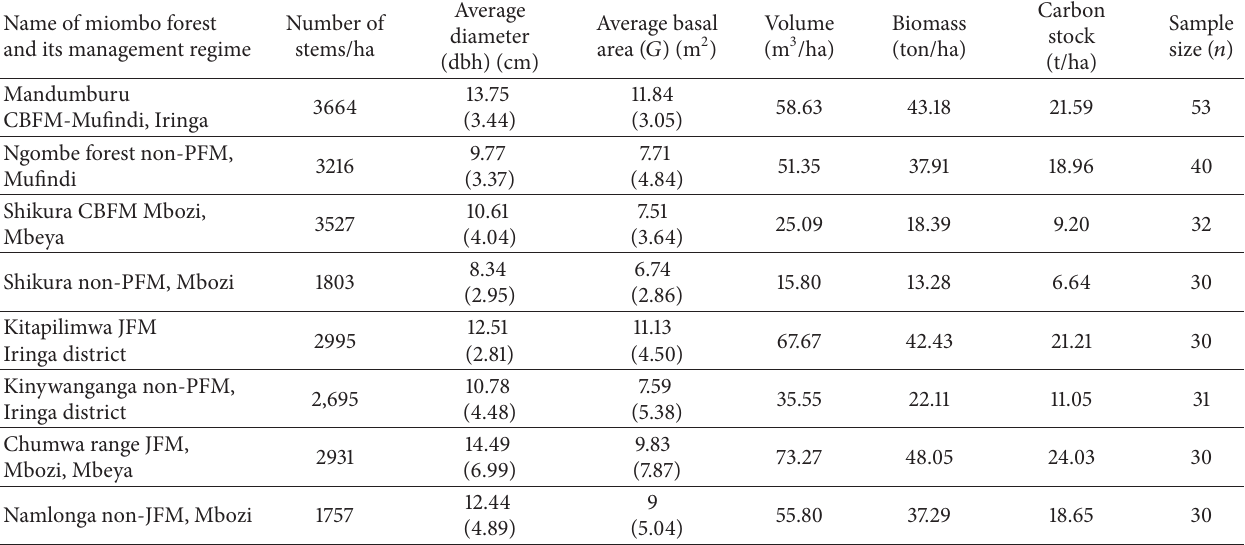
Table 6: Influence of PFM on the growth of miombo woodland as compared to non-PFM. Name of miombo forest